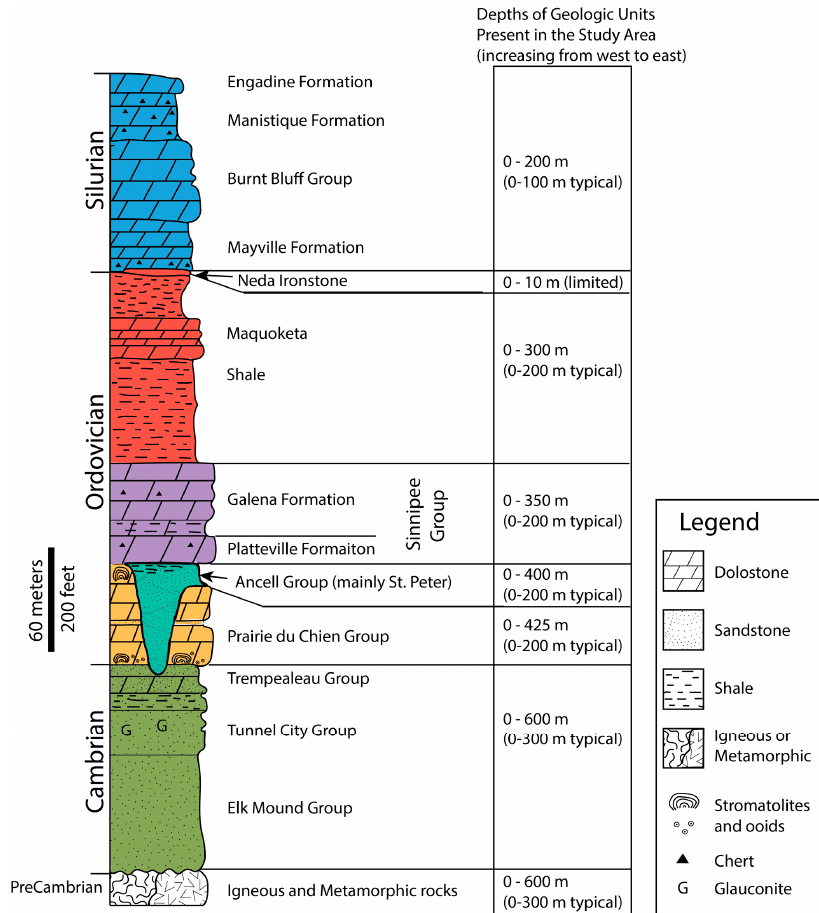
Figure 2. Simplified stratigraphic column for Paleozoic rocks in northeastern Wisconsin, USA [13]. Pleistocene sediments and younger Silurian and Devonian strata for southeastern Wisconsin are not shown here for simplicity, but can be found elsewhere [27,28].